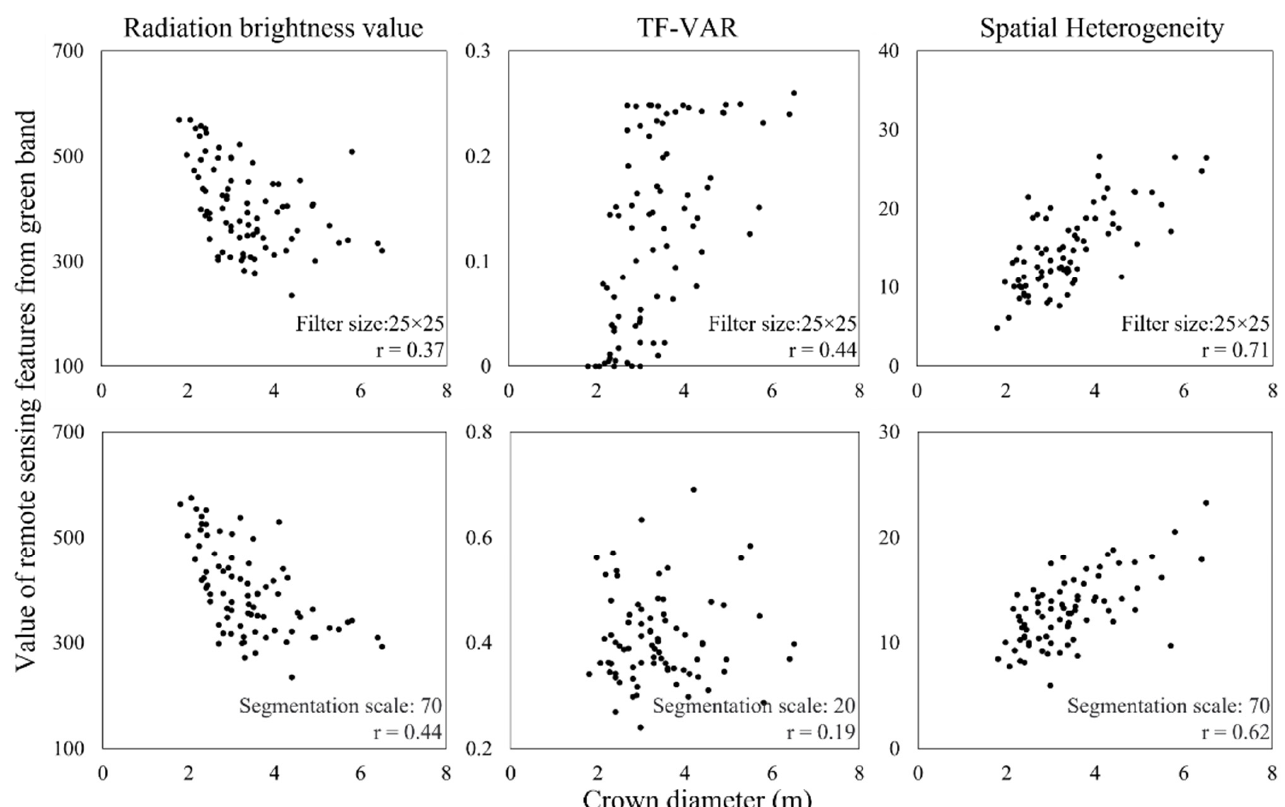
Figure 10. Sca tt er plots of CDs and partial variables extracted from the green band. Figure 10. Scatter plots of CDs and partial variables extracted from the green